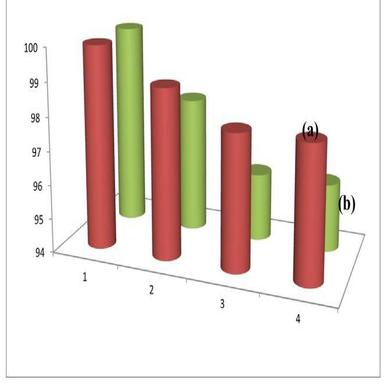
Stability and Reusability on NBBdye degradation; (a) CdO-SnO2 and (b) SnO2 nanocomposite material.